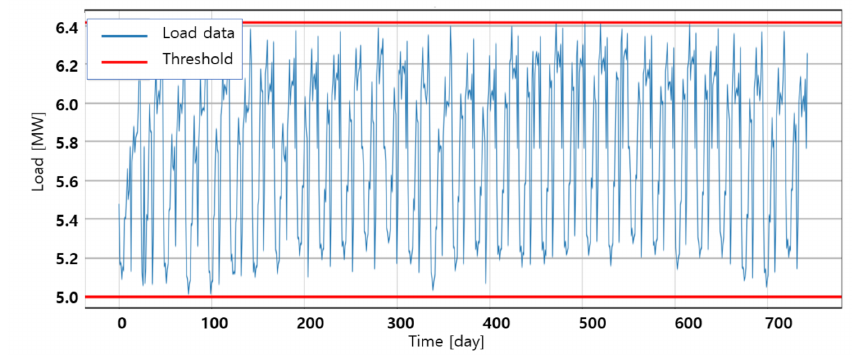
Figure 5. Example of the daily load patterns with the daily pattern